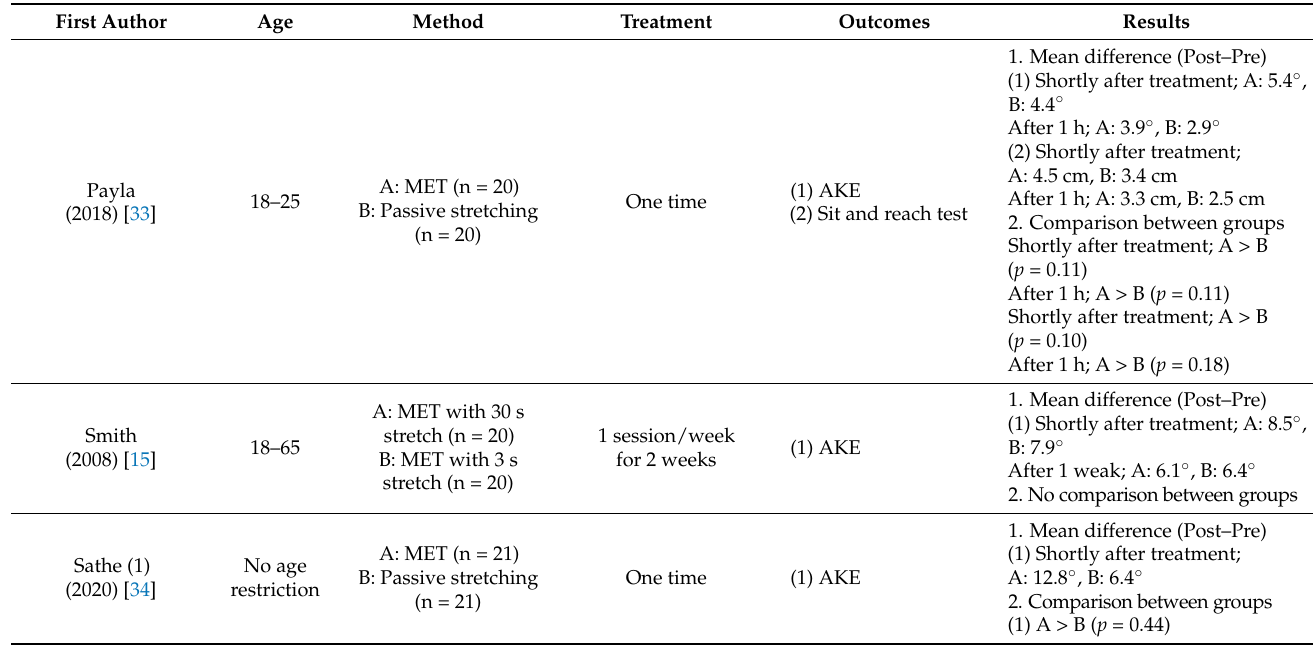
Table 1. Clinical studies on the use of MET on the hamstrings.